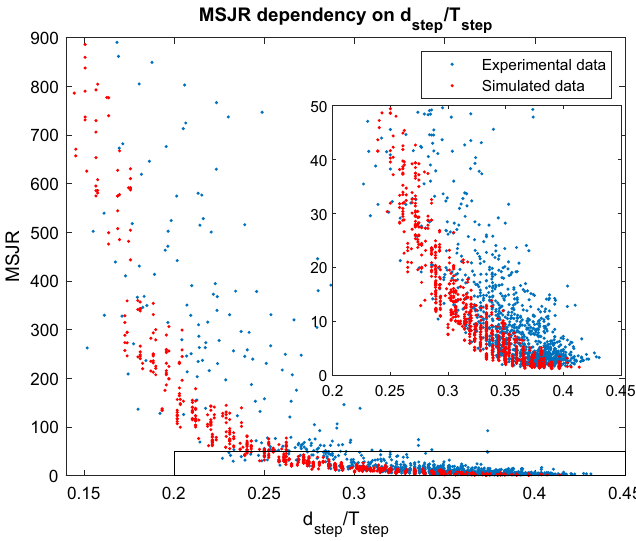
Figure 6. MSJR vs stride Swing/Period ratio from simulated and measured data; Blue: simulated gait for different speeds, with different step amplitudes and swing durations; Red: MSJR computed on data from subjects across five different speeds, fit to an exponential curve. Both simulated and measured MSJR exhibit an exponential decrease in MSJR with increased swing/period ratio, although the experimental data has a greater dispersion. Inner plot is zoomed to MSJR = (0,